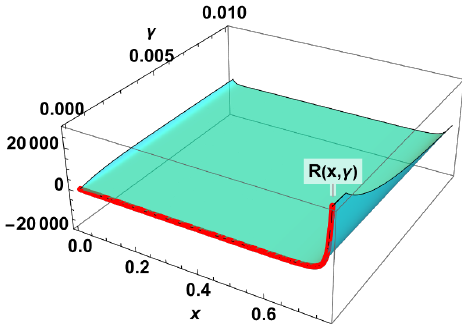
' 0 . 8 . The solid λ